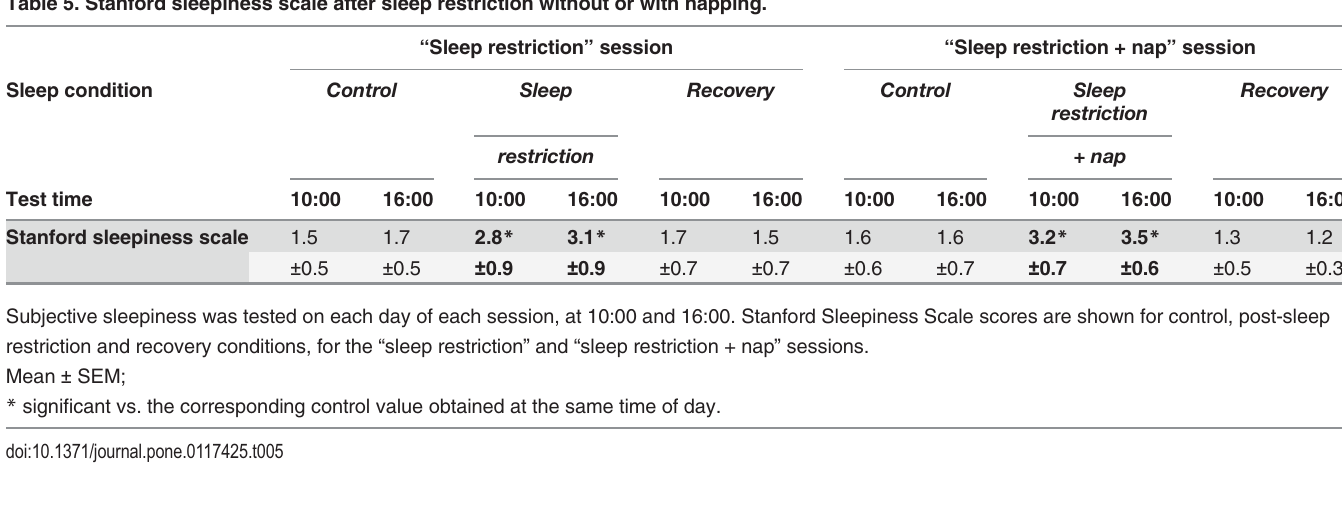
that cold stimuli may induce local vasomotor changes [29]. The vascular modifications induced by thermal stimuli in distal parts of the body, such as the hand, could be assessed by Döppler analyses in QST studies.